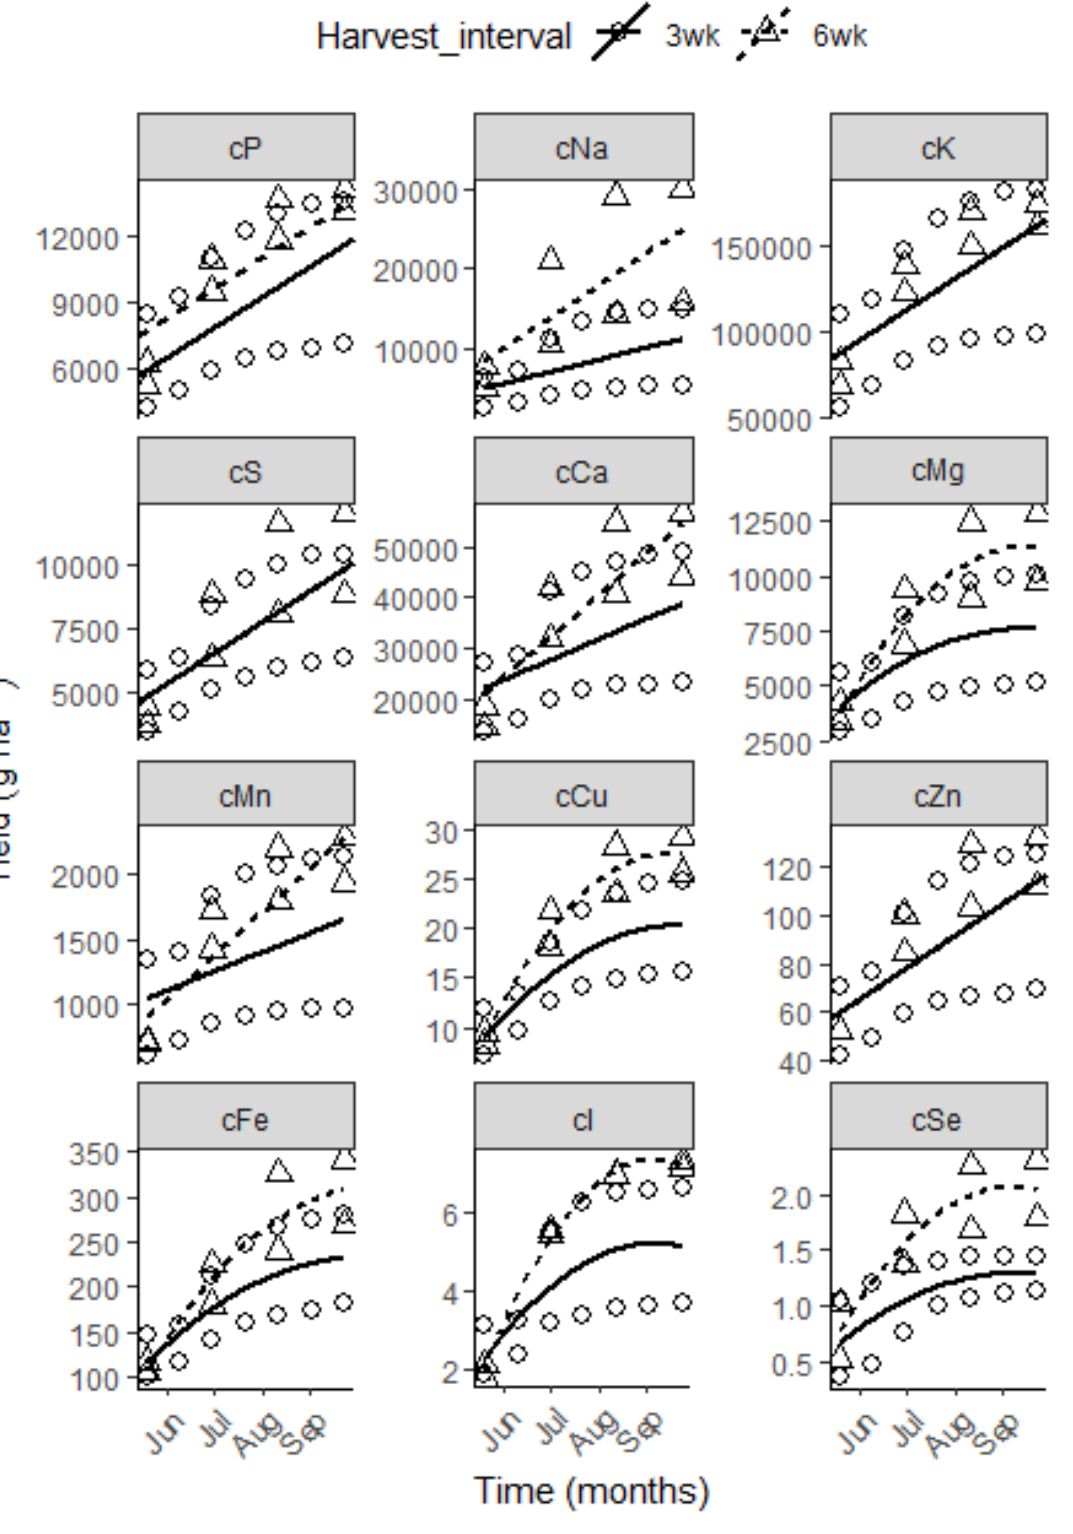
Figure 6. Experiment III: Effect of harvest interval (3-week or 6-week intervals) on cumulative (c) mineral yields of T. latifolia biomass one year after planting. Harvest dates were 19 May, 02 June, 30 June, 21 July, 11 August, 01 September and 22 September 2017. Each set of points per harvest date (n = 2) represents biomass nutrient concentrations from two different subplots. Fit parameters of the curves are shown in Table 7. Cumulative yields of K, S and Zn were approximated by (nearly) the same curve for both harvest intervals, therefore only the fitted curve for the 3-week interval is visible for these